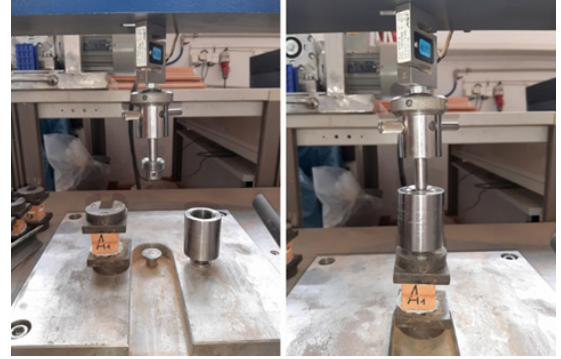
Figure 5. The sample preparation in a test apparatus.